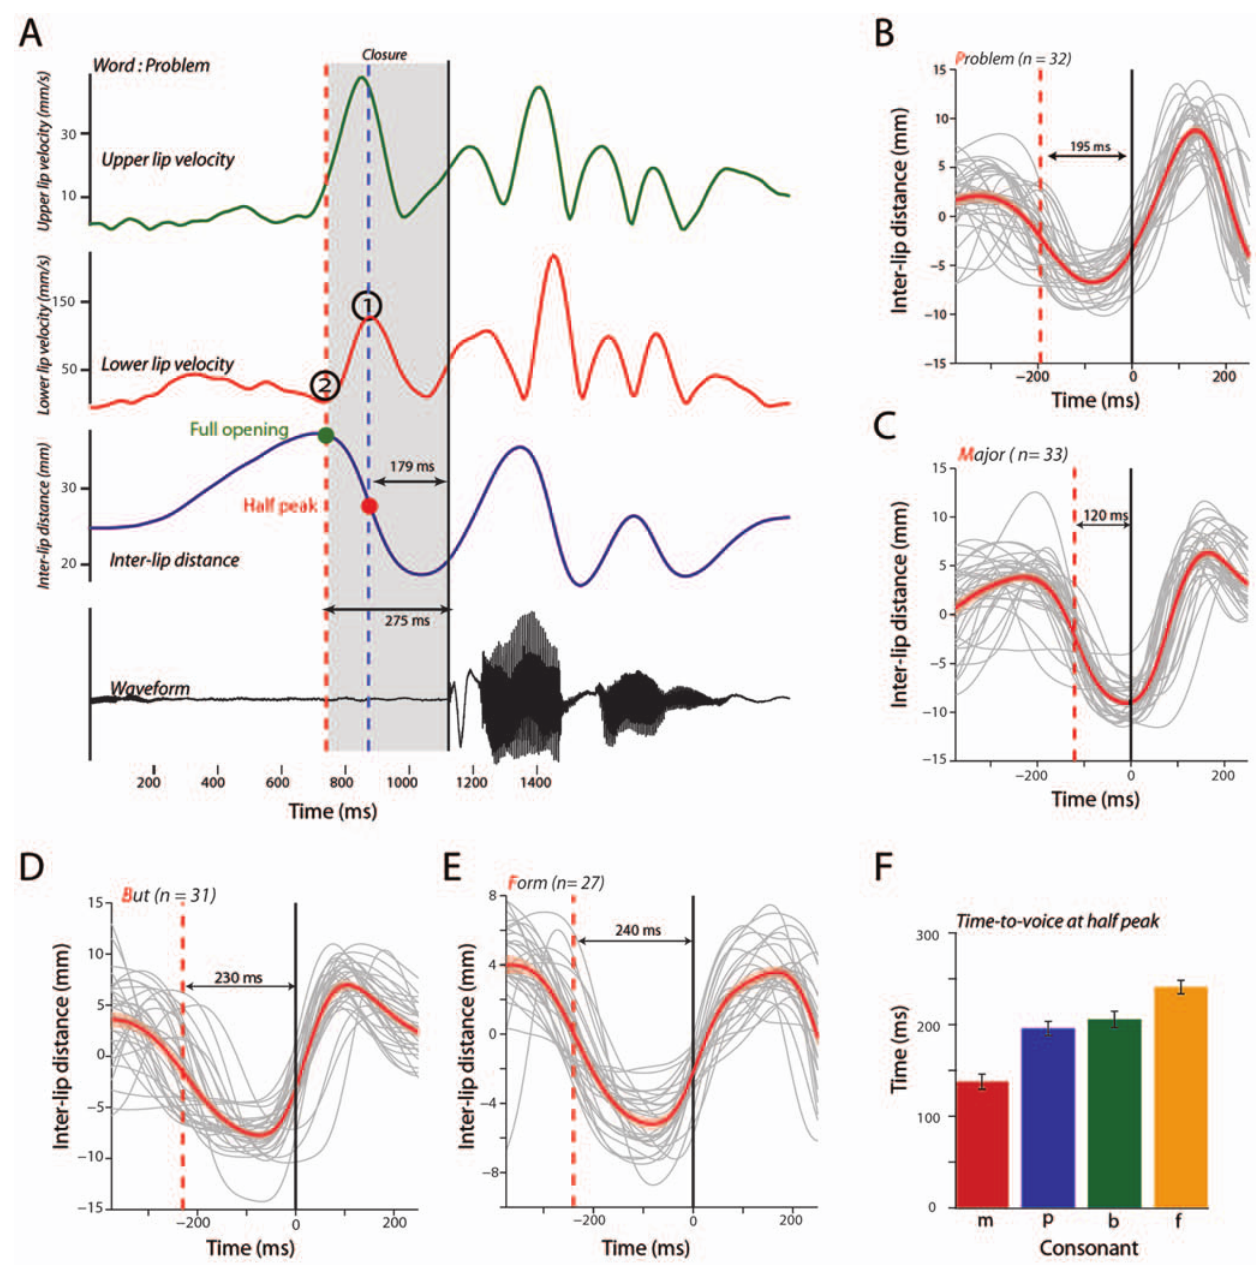
Figure 8. Measuring time-to-voice for consonants at the beginning of words. A - Visual and auditory dynamics during the production of the word ‘‘PROBLEM’’ by a single speaker. Green and red lines denote the velocity profiles of the upper and lower lips respectively. Dark blue line denotes the inter-lip distance as a function of time. The waveform of the sound is shown in black. Blue dashed line denotes the point of maximal lower lip velocity (marked by (1)). Red dashed line denotes the point of zero lower lip velocity (marked by (2)). Solid black line denotes the onset of the sound. The greens dot denotes the maximal mouth opening before onset of the sound. The red dot denotes the half peak point of the mouth opening. X-axes depict time in milliseconds. B - Inter-lip distance for different subjects and average as a function of time for the bilabial plosive /p/ aligned to the onset of the sound. Red dashed line denotes the half peak opening of the mouth. X-axes depict time in milliseconds, y-axes depict inter-lip distance in mm. Solid dark line denotes the onset of the sound. Gray lines denote traces from individual subjects. Red line denotes the average across subjects. Shaded regions denote the standard error of the mean. C - Inter-lip distance for different subjects and average as a function of time for the bilabial consonant /m/ aligned to the onset of the sound. Figure conventions as in B. D - Inter-lip distance for different subjects and average as a function of time for the bilabial plosive /b/ aligned to the onset of the sound. Figure conventions as in B. E - Inter-lip distance for different subjects and average as a function of time for the labiodental /f/ aligned to the onset of the sound. Figure conventions as in B. F - Average time to half opening from the onset of the sound for the three bilabial consonants and the labiodental across subjects. Error bars denote the standard error of the mean.